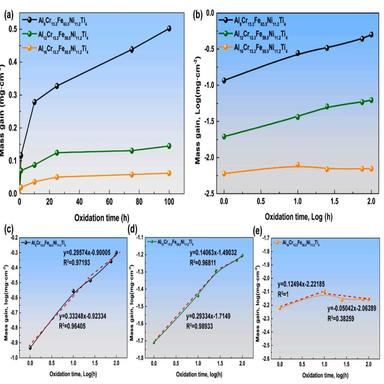
Mass gains per unit area as a function of oxidation time for Fe71.5-x(Ni, Cr, Ti)28.5Alx CCAs at 800 ◦C in air.